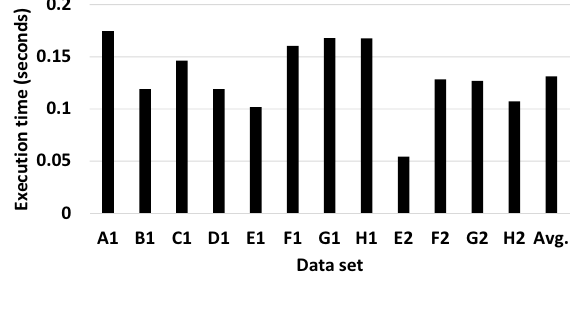
Fig. 6. Execution time for